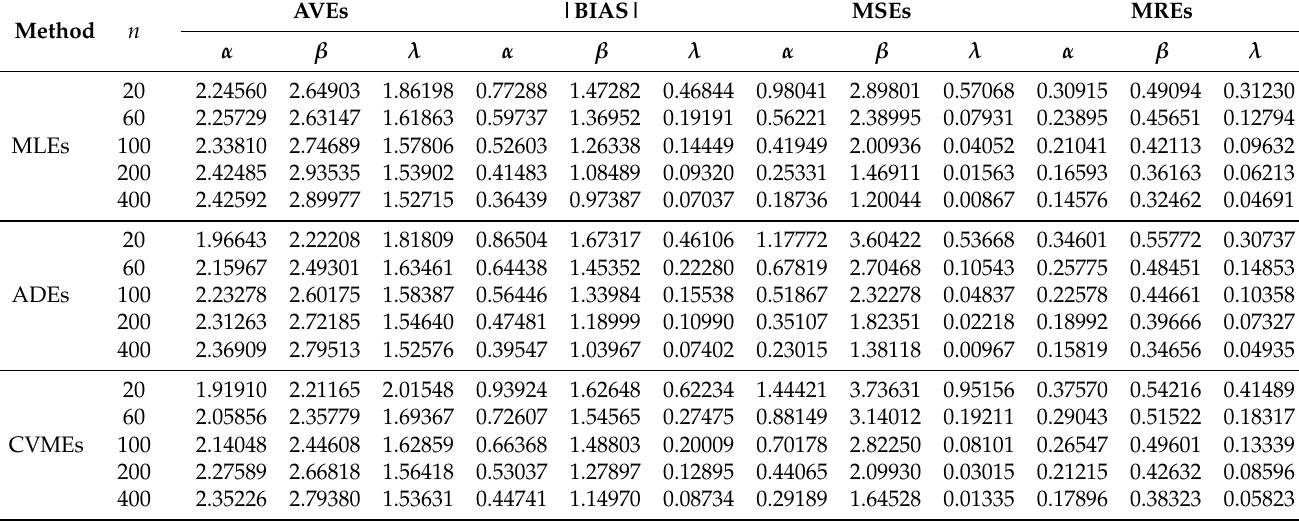
Table 5. Numerical values of the Ex-LL distribution for the parameters α = 2.5, β = 3, λ =